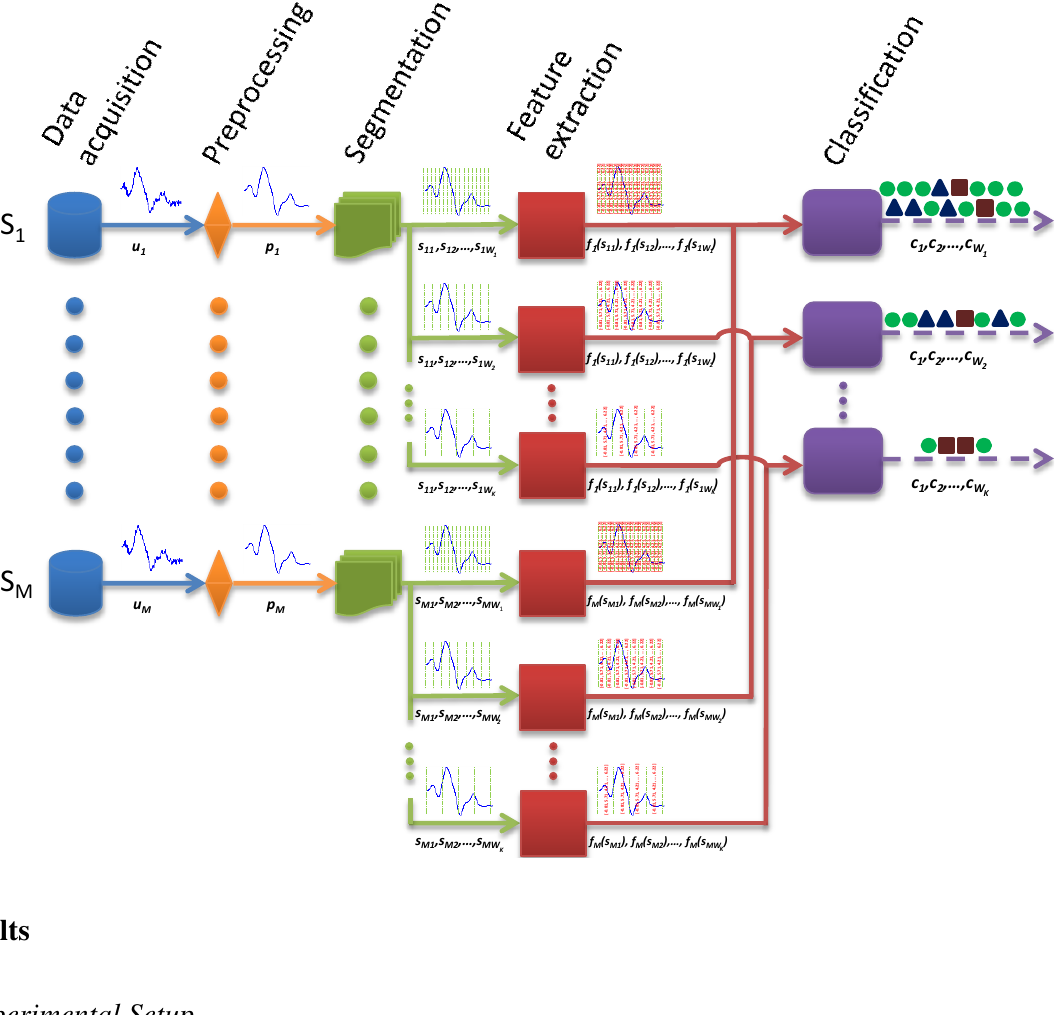
Figure 2. Different stages of the activity recognition chain (ARC). An example of the correlation of the windowing approach and subsequent levels of the ARC is shown. Concretely, M sensors